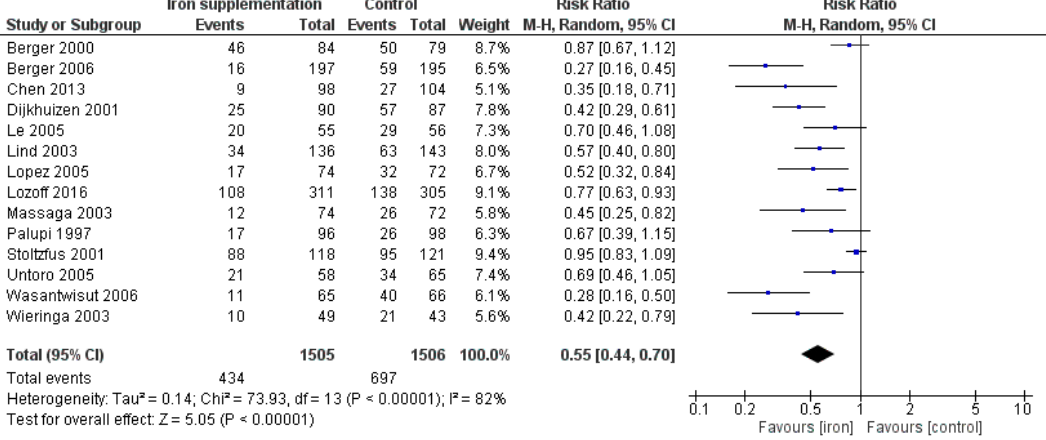
Figure 3. Iron-folic acid supplementation versus placebo/no intervention (efficacy studies) on the risk of anemia (hemoglobin concentration < 110 g/L). 3.2.5. Efficacy of MMN Supplementation MMN supplementation was associated with a reduced risk of anemia (RR 0.69, 95% CI 0.56 to 0.85; I 2 = 79%, p = 0.0004) (Figure 4). There appeared to be a greater reduction in risk of anemia among children aged 6–11 months compared to those aged 1–5 months at baseline ( p for subgroup differences = 0.03), and among children who took MMN supplementation daily as compared to intermittently ( p for subgroup differences = 0.05). Significant differences were also observed by region, where greater reductions in the risk of anemia were noted among children in the Americas, Western Pacific, and African regions, as compared to Southeast Asia ( p for subgroup differences = 0.001), though sample size was not evenly dispersed among regions. MMN supplementation was associated with increased height (MD 0.36 cm, 95% CI 0.01 to 0.71; I 2 = 0%, p = 0.04), length-for-age (z-score) (MD 0.09, 95% CI 0.00 to 0.17; I 2 = 43%, p = 0.04), hemoglobin concentration (MD 4.40 g/L,